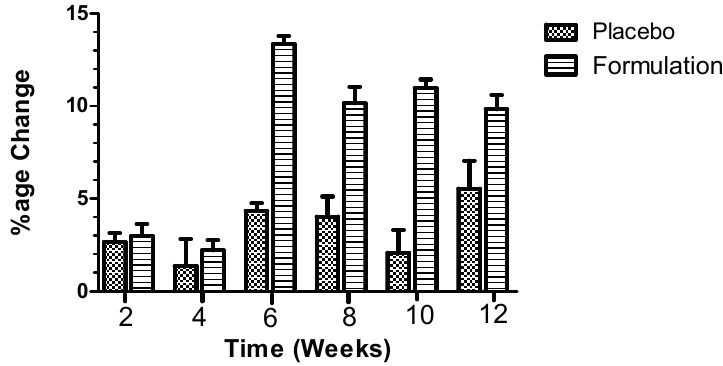
Figure 1. Percentage of change produced in skin hydration (SH) values after application of placebo and active formulation in respective cheeks of volunteers ( n = 13). Bars represent mean standard deviation (s.d.) of three independent experiments. Statistical significance ( p ˂ 0.05) results were obtained at sixth, eighth, 10th and 12th week, in favor of the active formulation.